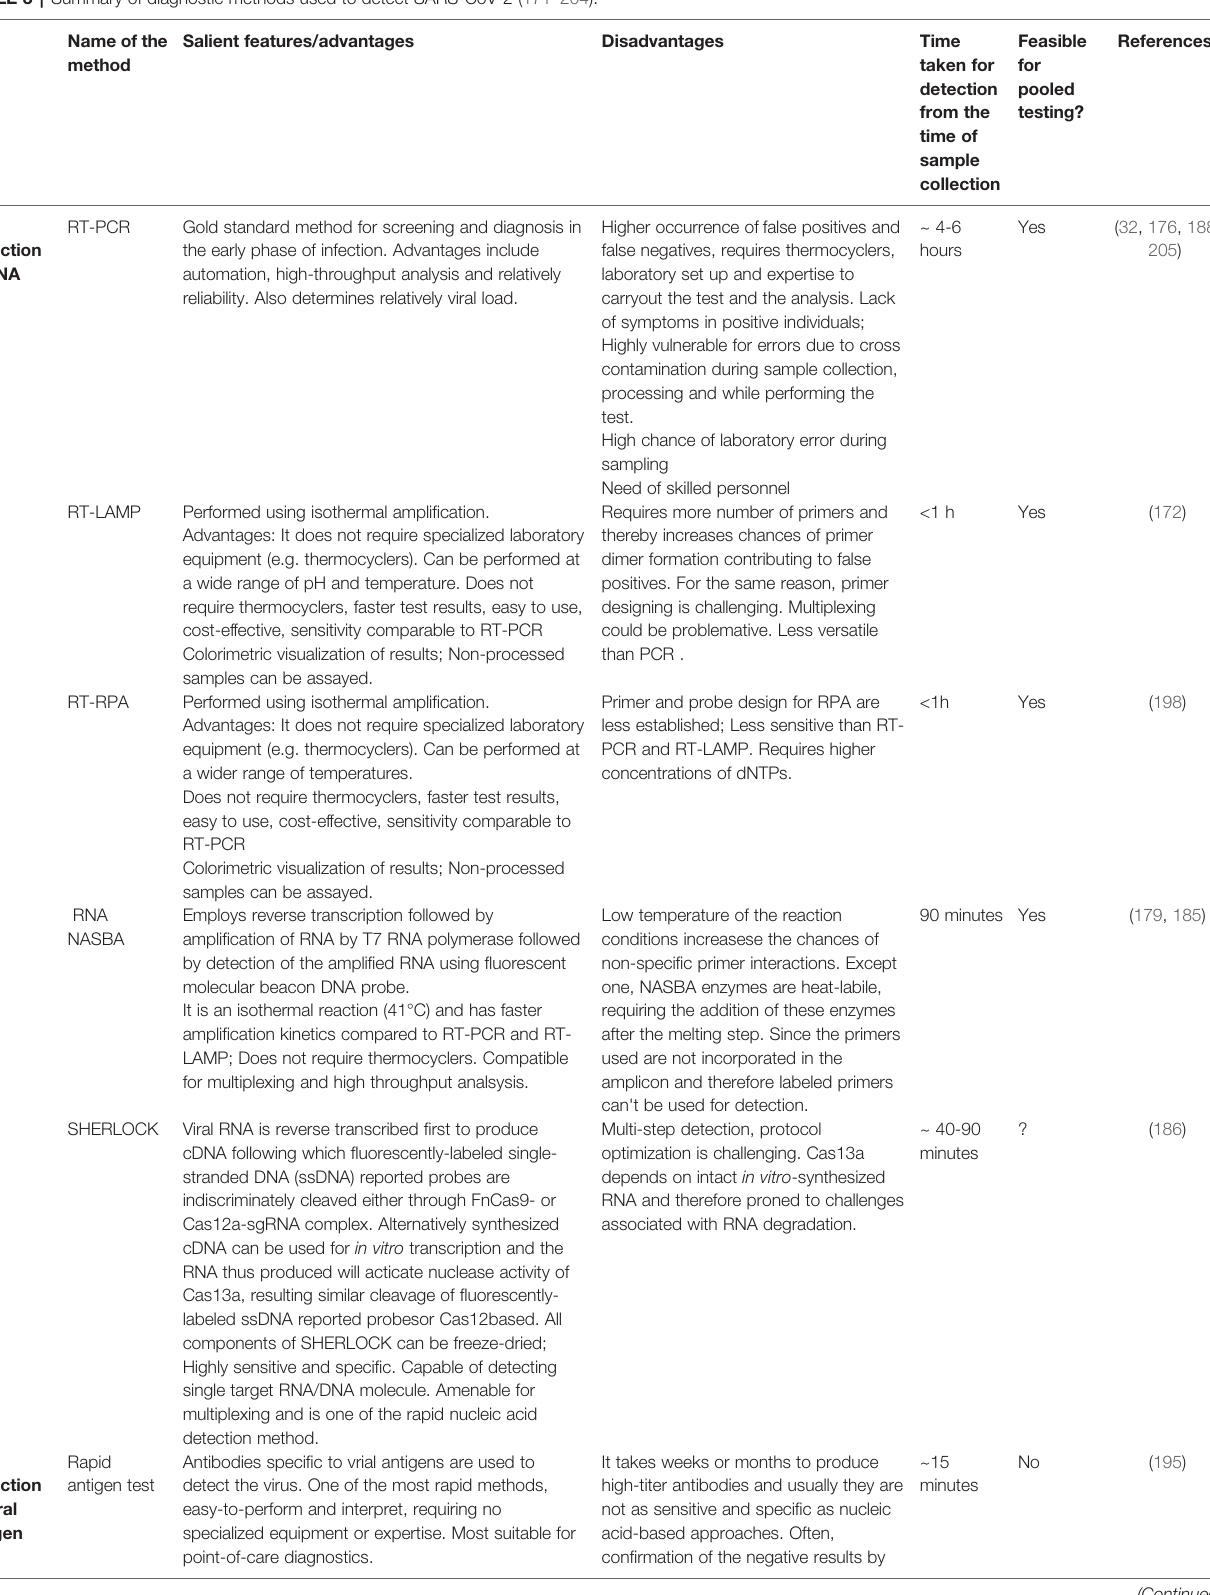
TABLE 3 | Summary of diagnostic methods used to detect SARS-CoV-2 (171 – 204). Name of the